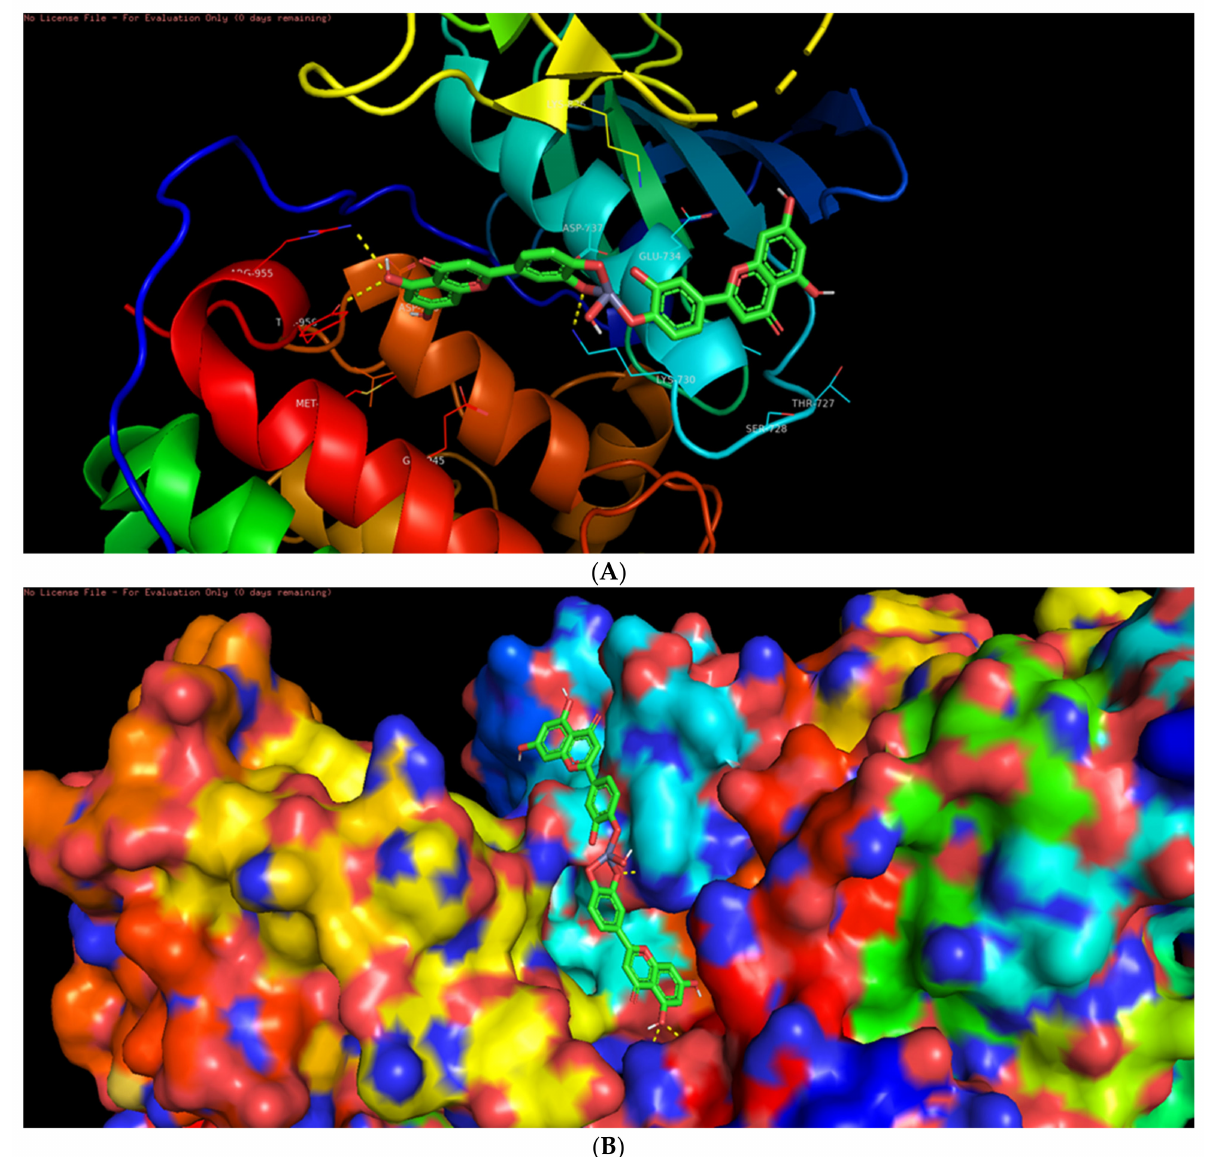
Figure 12. ( A ) The bonded and non-bonded interactions of L-ZnONPs with the cancer protein 4RIW. ( B ) The best-docked pose of L-ZnONPs bound to the hydrophobic preset of the 4RIW